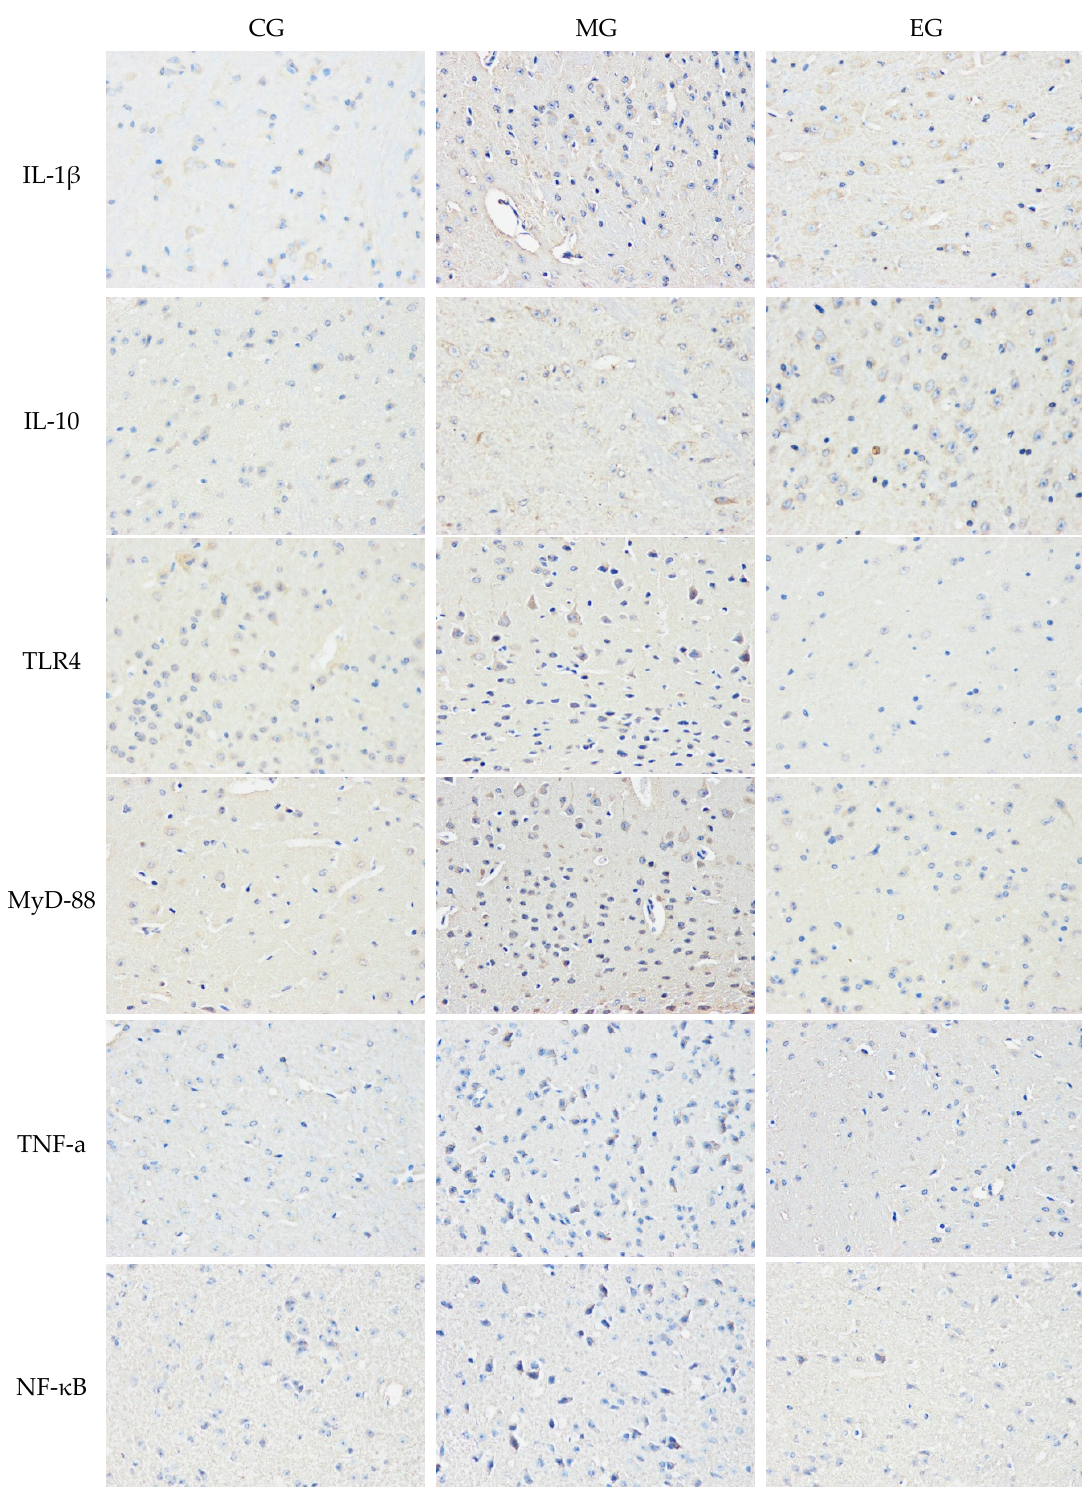
Figure 5. The immunohistochemical detection results of inflammation-related factors in the hippocampus of CUMS mice after 8 weeks of exercise (original magnification 400×). There were six mice for immunohistochemistry analysis in each group. Three fields of view were randomly selected for immunohistochemically staining from the hippocampus of the section, and analyzed by CIIAS98 color pathological image analysis system.